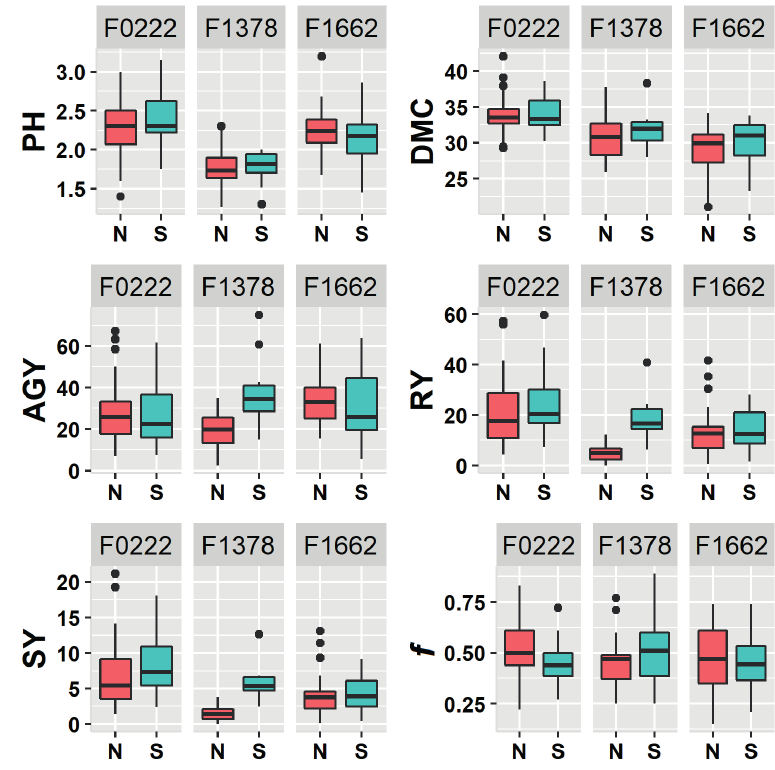
cassava individuals from the self-pollination Figure 6 - Boxplot of the selection of S 1 of accessions BGM0222 (F0222), BGM1378 (F1378) and BGM1662 (F1662), based on the selection index. S and N: S selected and unselect individuals by the selection 1 index, respectively. PH: plant height (m); DMC: root dry matter content (%); AGY: above ground yield (t.ha -1 ); RY: root yield (t.ha -1 ); SY: starch yield (t.ha -1